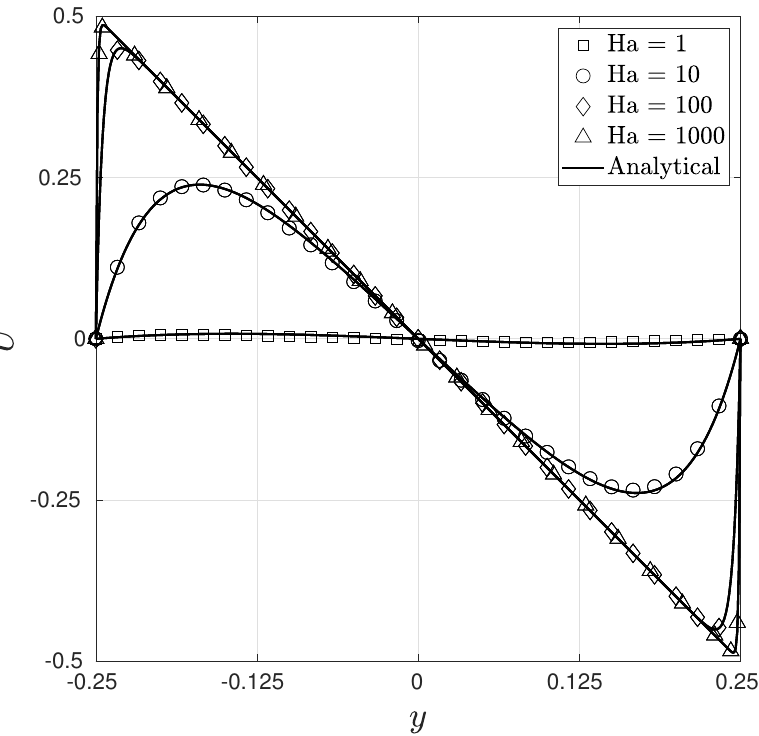
Figure 7. Comparison of the numerical and analytical solutions for the non-dimensional velocity U along the center plane x = 0 for the two-dimensional buoyancy-driven flow problem.